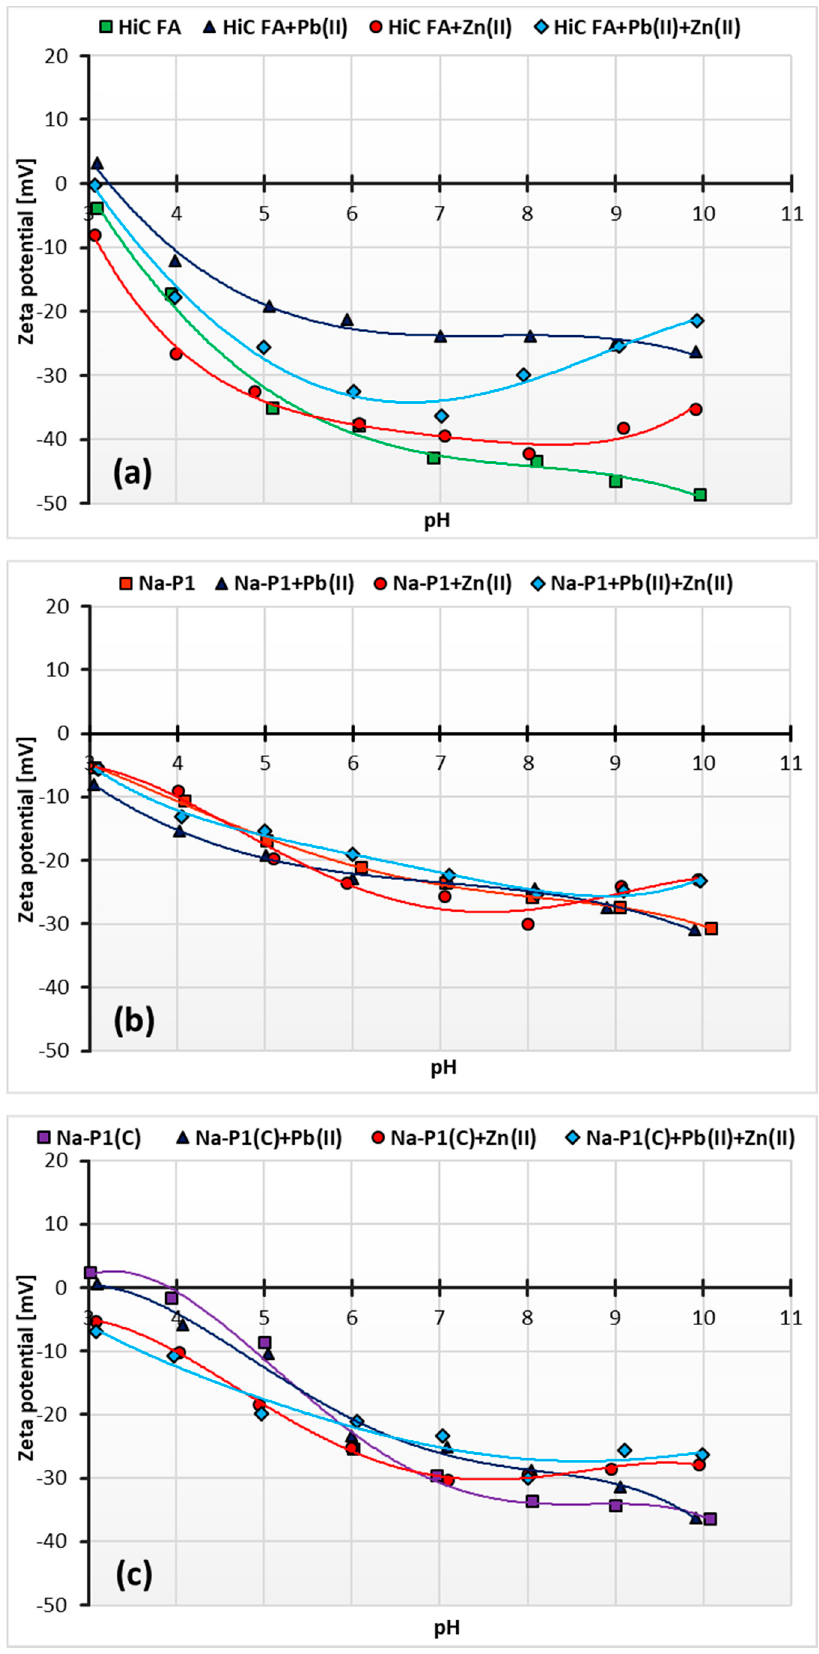
Figure 12. Zeta potential of the HiC FA 9 ( a ), Na-P1 ( b ) and Na-P1(C) ( c ) without and with one or two heavy metal ions.